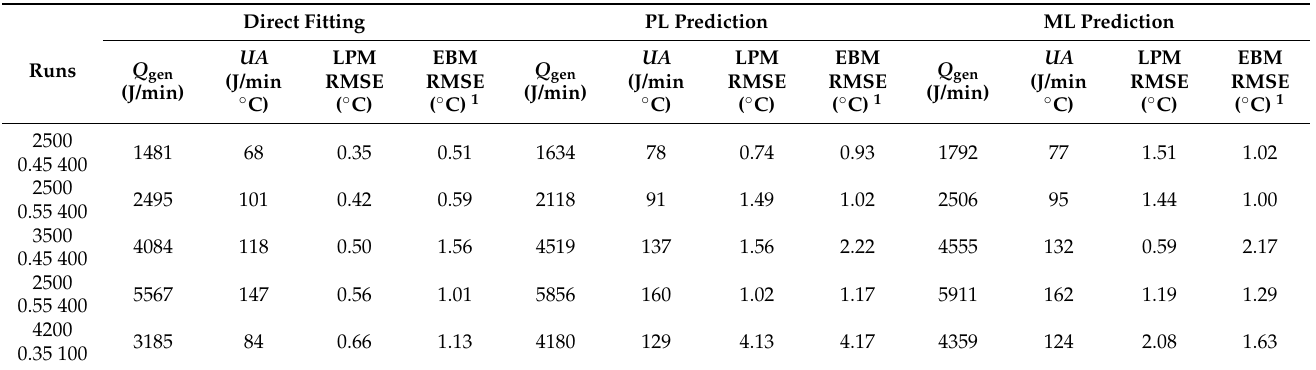
Table 3. Parameters of the LPM estimated by direct fitting as well as predicted using the PL and ML models coupled to the LPM along with the associated statistics.